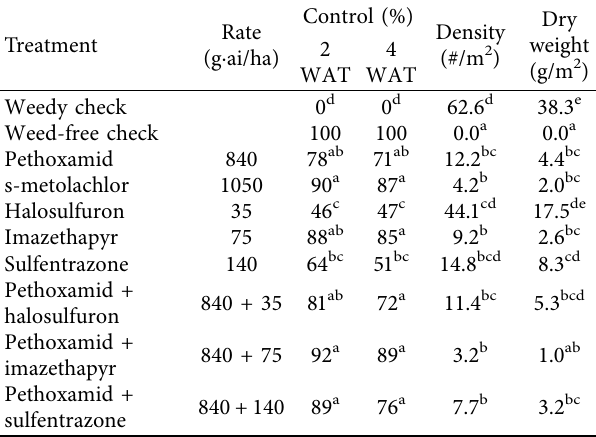
Table 5: Percent control, density, and dry weight of green foxtail 2 and 4 weeks after herbicide treatment (WAT) in white bean treated with pethoxamid applied PRE in 2015, 2016, and 2017.